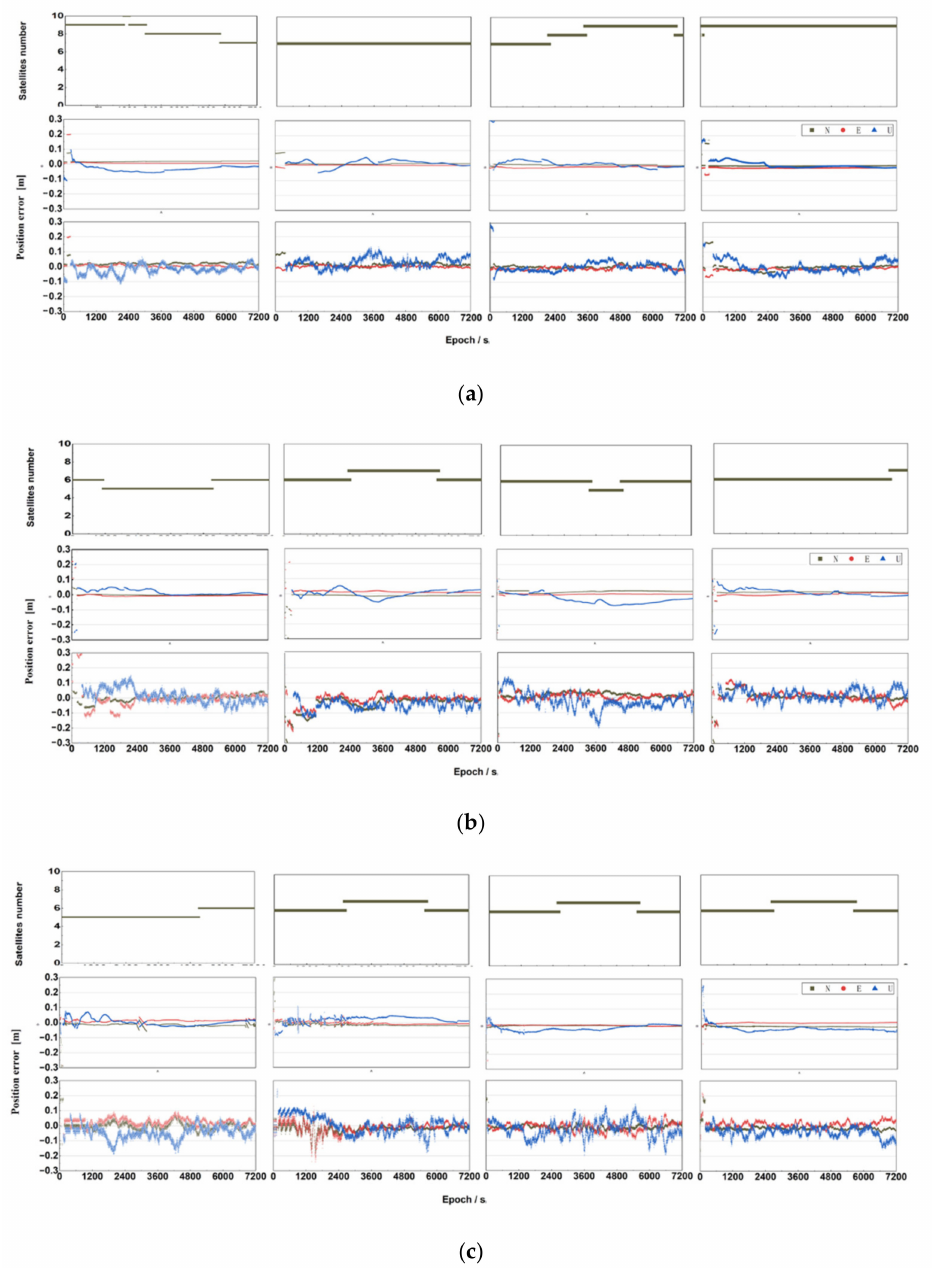
Figure 13. The positioning results for Baselines A ( a ), Baseline B ( b ) and Baseline C ( c ). In each row, there are four subplots representing four 2-hour sessions. In each subplot, the top panel shows the number of satellites observed and the middle and bottom panel for the position differences in static and kinematic mode,